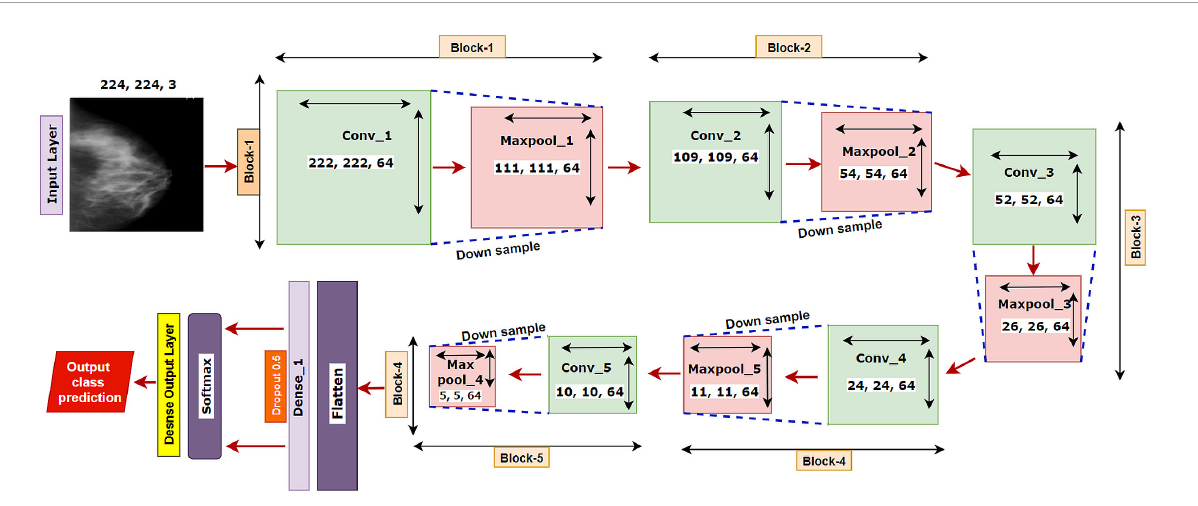
FIGURE5 The architecture of the base